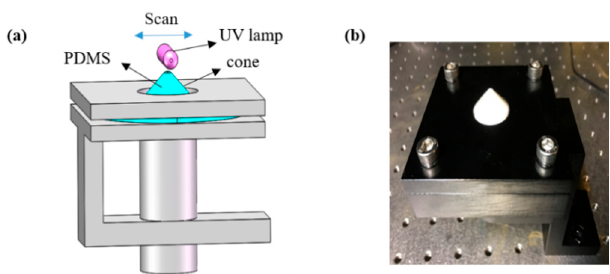
Figure 4. ( a ) Schematic diagram of the experimental device used to prepare ring wrinkles with a continuously changing wavelength. The PDMS membrane was fixed between two plates with round holes and then stretched by a Teflon cone. The UV lamp evenly scanned the substrate. ( b ) Photograph of the experimental setup.